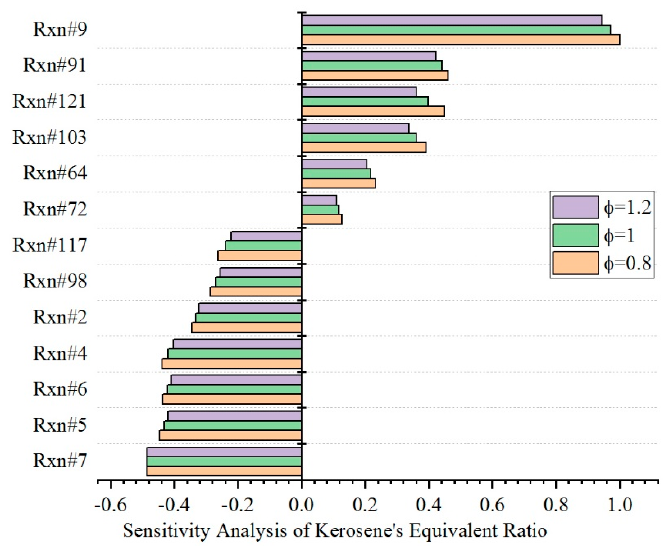
Figure 5. Sensitivity analysis of kerosene under different equivalence ratios.